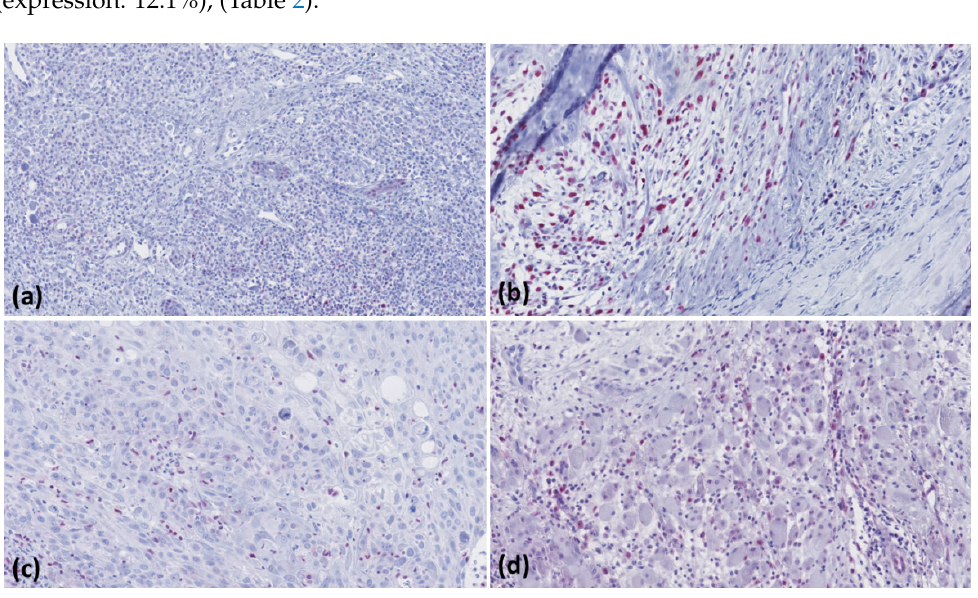
Figure 2. Showing immunohistology images (magnification: ×200) with low-level (<50%) nuclear expression of mismatch repair proteins; MSH2 ( a , cSCC > 6 mm), MSH6 ( b , cSCC-M), MLH1 ( c , cSCC < 2 mm), and PMS2 ( d , cSCC > 6 mm).